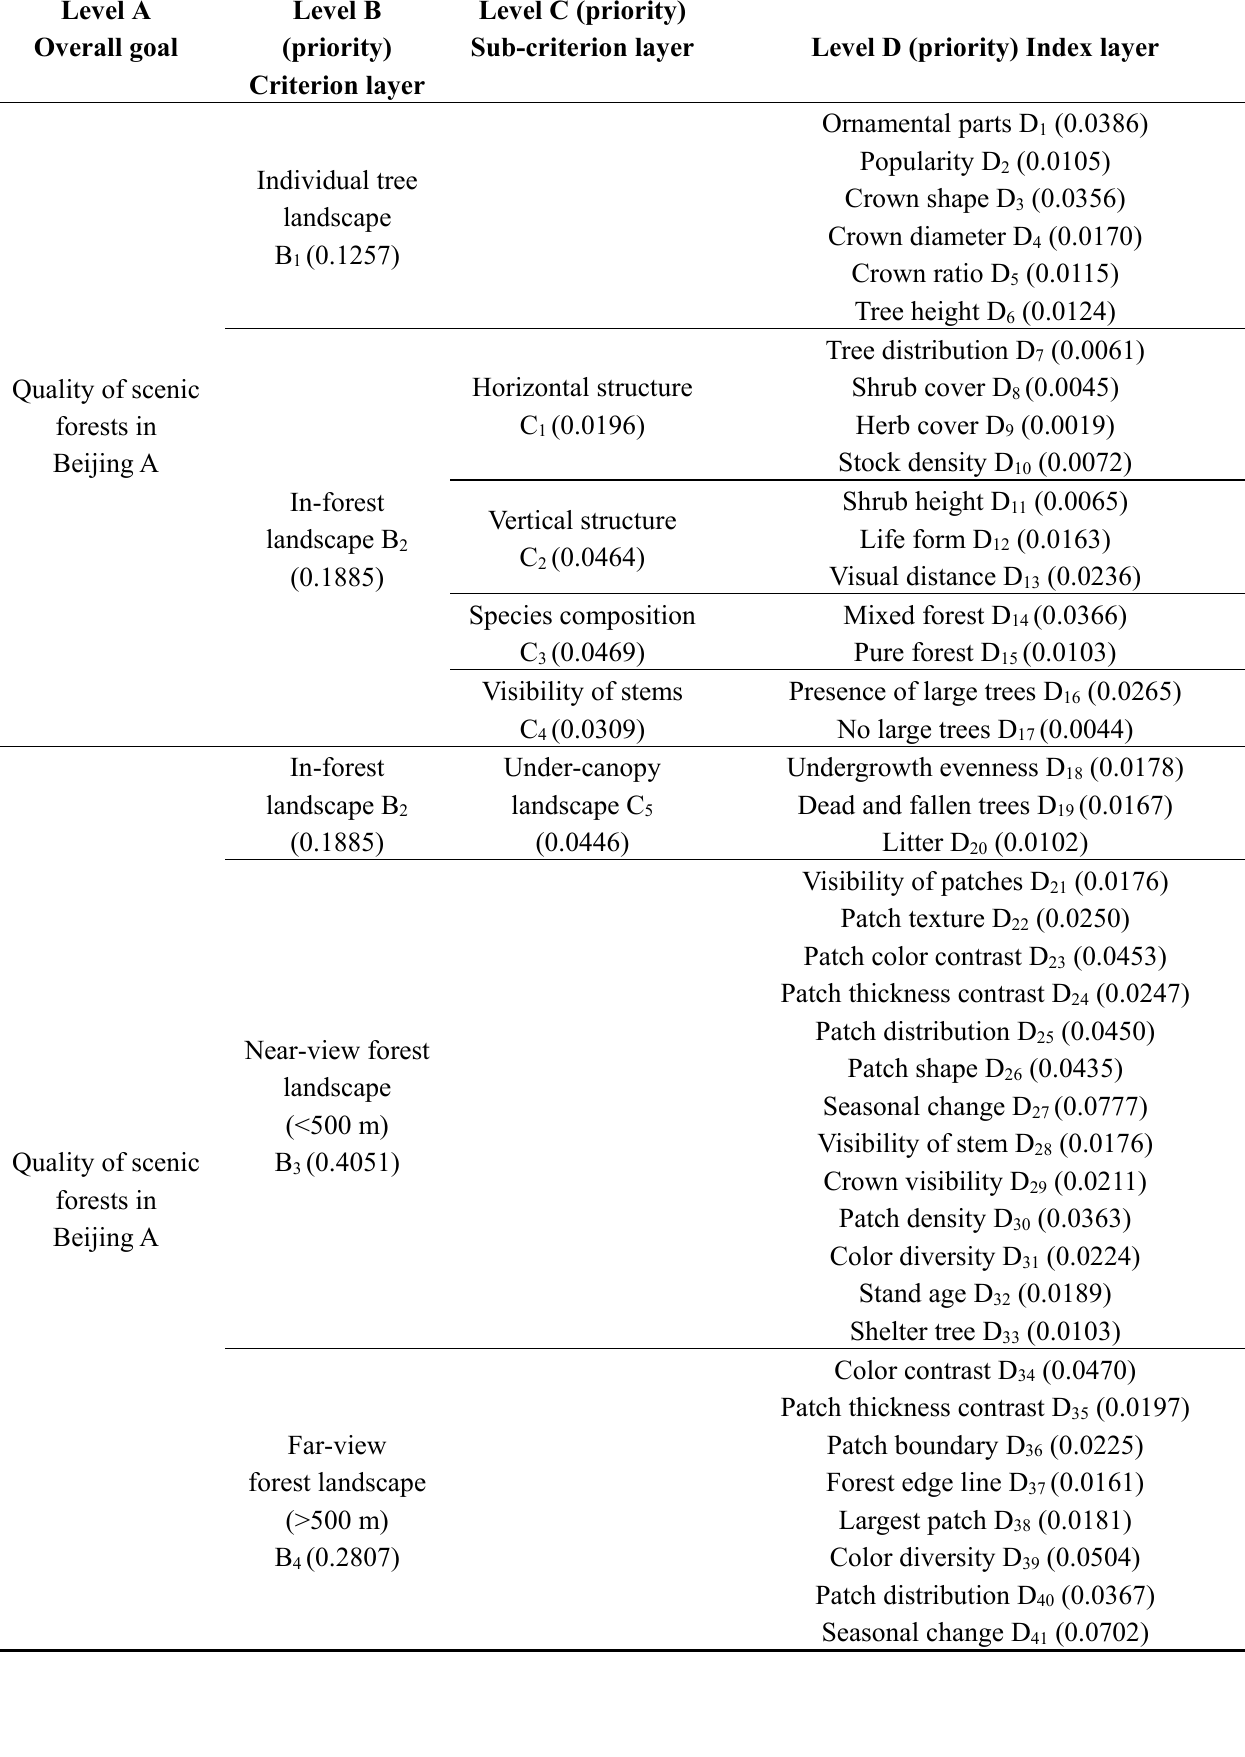
Table 1. Hierarchy and priorities of indices for the assessment of scenic forest